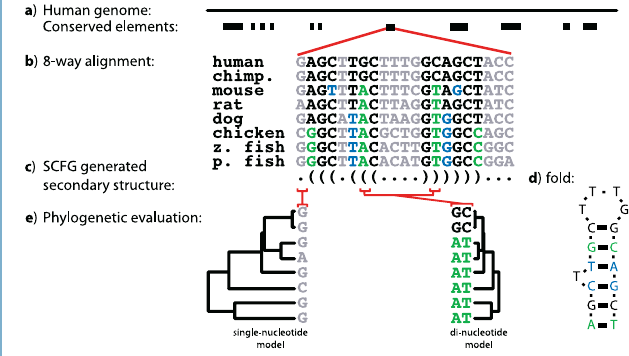
Figure 1. Outline of EvoFold Prediction Method (A) Schematic representation of human genome and conserved elements. The conserved elements define the input alignments. (B) Segment of eight-way genomic alignment. (C) The SCFG of the fRNA model defines a distribution over all possible secondary-structure annotations. One of the many possible secondary structures is shown in parenthesis format. Substitutions in pairing regions of the alignment are color-coded relative to human: compensa- tory double substitutions are green, and compatible single substitutions are blue. (D) Color-coded fold corresponding to the secondary-structure annota- tion of the alignment. (E) Two phylogenetic models are used to evaluate the possible secondary-structure annotations: unpaired columns are evaluated using a single-nucleotide phylogenetic model. Paired columns are combined and evaluated using a di-nucleotide phylogenetic model. Horizontal branch lengths reflect the expected number of substitutions. DOI: